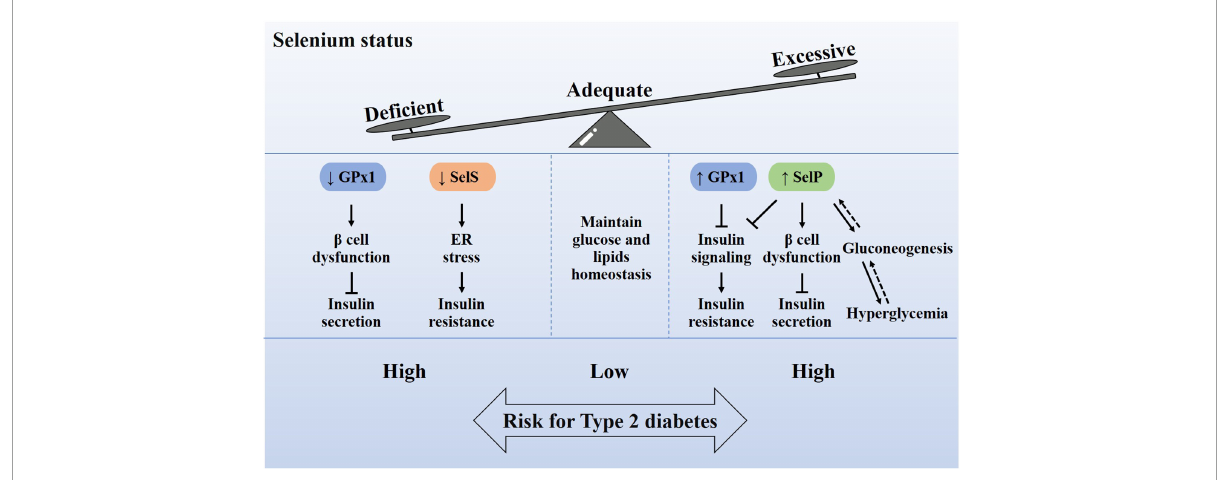
FIGURE3 Relationship between selenium homeostasis and type 2 diabetes. Adequate selenium intake is very important for maintaining the homeostasis of glucose and lipid metabolism. Excessive or insufficient selenium intake will cause the increase or decrease of selenoproteins in the body, which in turn leads to a high risk of type 2 diabetes. The abnormal content of selenoproteins, including Gpx1, SelP, and SelS, may cause oxidative damage of β cells, insulin signaling impairment, endoplasmic reticulum stress and gluconeogenesis, which induce insulin secretion defects or insulin resistance. Therefore, it is recommended to supplement selenium according to the state of